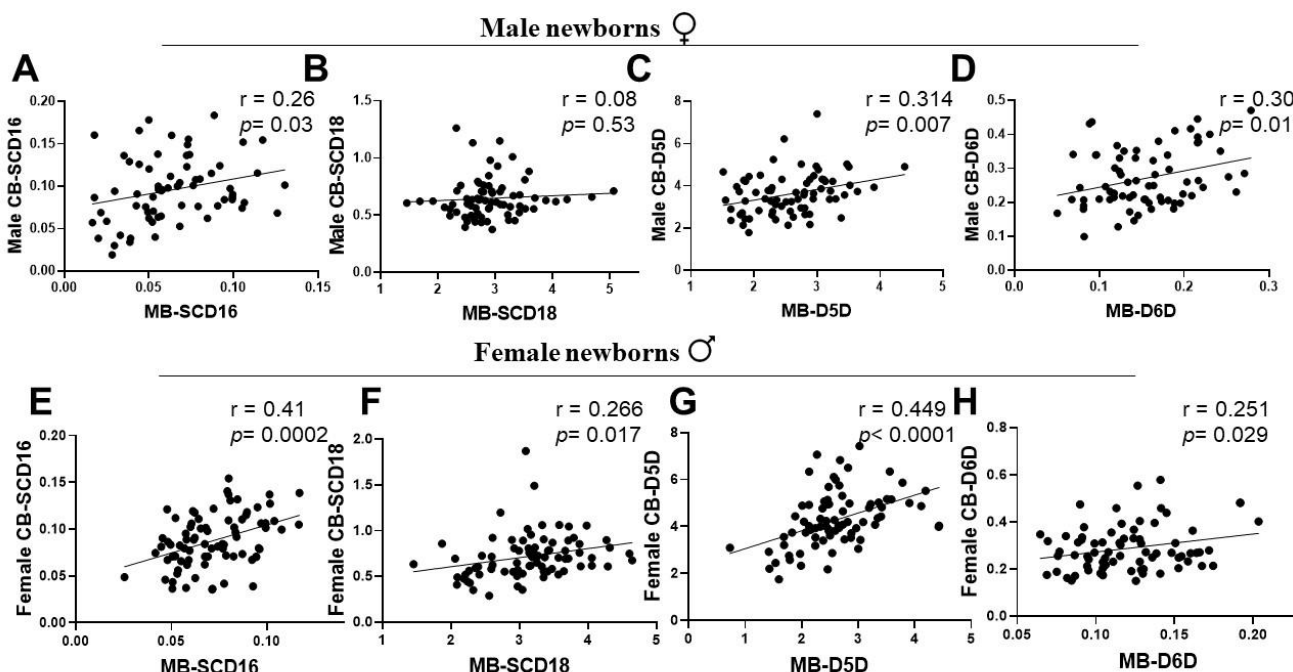
Figure 4. Cord blood fatty acid desaturation indices are positively associated with maternal fatty acid desaturation indices. ( A – D ) SCD16, SCD18, D5D and D6D indices of MB versus CB desaturation indices of male newborn group. ( E – H ) SCD16, SCD18, D5D and D6D indices of MB versus CB desaturation indices of female newborn group. MB versus CB correlations for SCD16, D5D and D6D indices are significantly positive. For SCD18 index, only MB and CB of female newborns are positive and remarkably significant (however, there was no relationship between MB versus CB SCD18 of male newborns). SCD, stearoyl CoA desaturase; D5D, delta-5-desaturase; D6D, delta-6-desaturase. MB, plasma of mother blood; CB, plasma of cord blood.